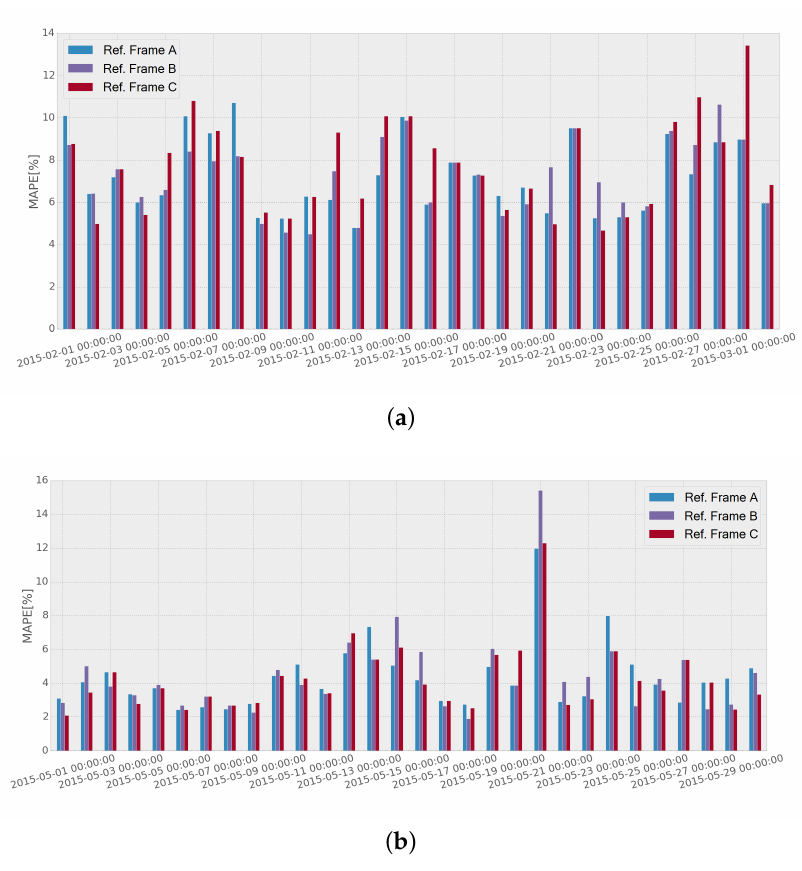
Figure 12. Comparison of the performance using the different procedures: ( a ) Network 1 and; ( b ) Network 2.